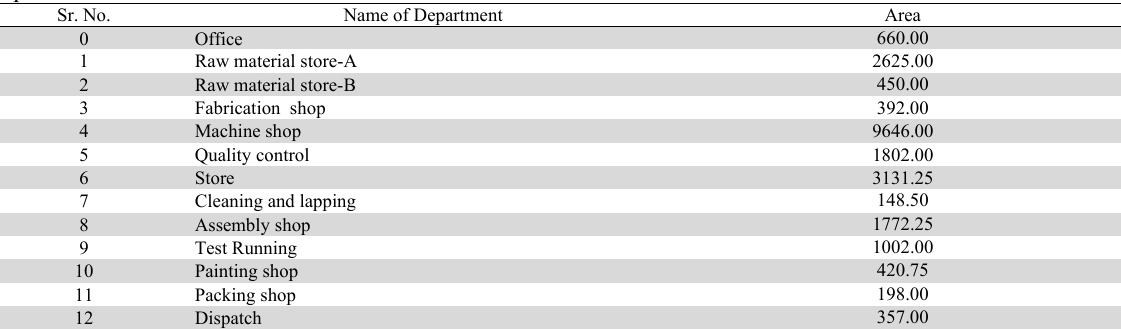
Departments and their